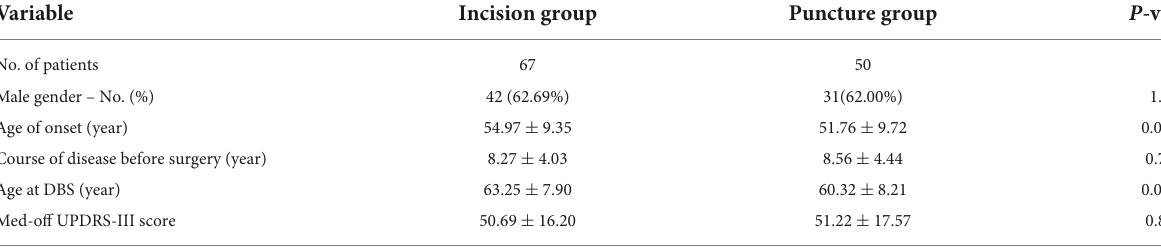
TABLE 1 Patient baseline characteristics by methods of opening the